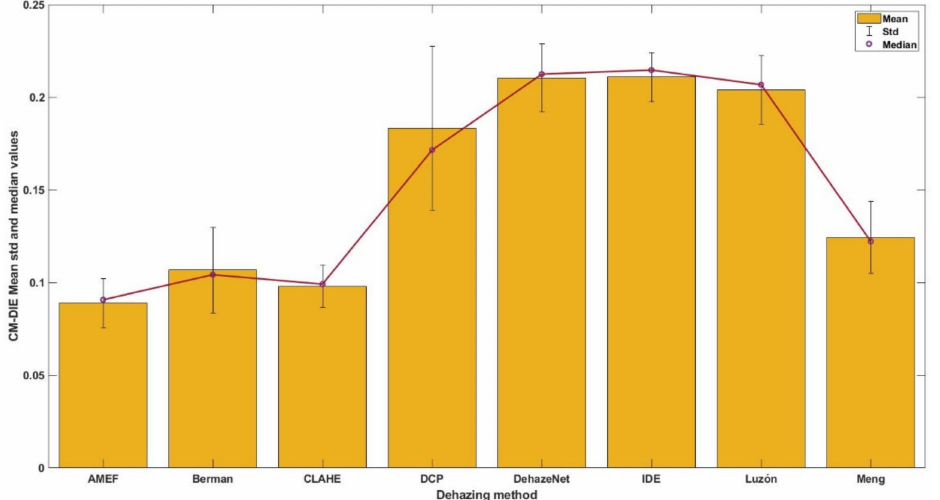
Figure 2. Mean and median of the CM-DIE for each dehazing algorithm in the 1540 band combina- tions tested. The yellow bars refer to the mean values whilst the blue points represent the median values. The standard deviation values are shown as error